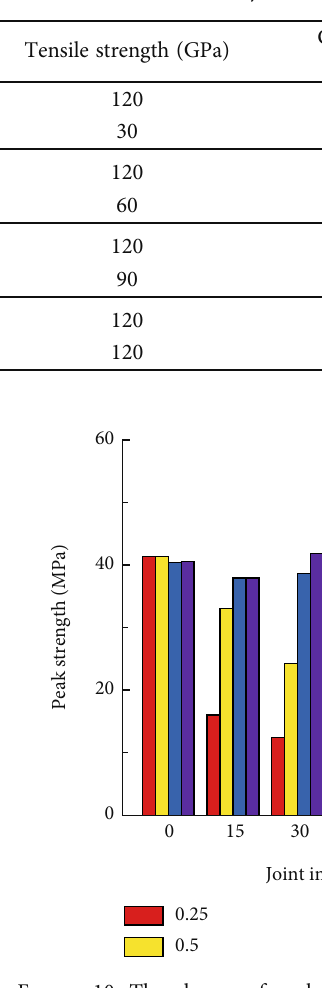
Figure 9: Uniaxial compression failure mode of rock samples with columnar Table 2: Numerical simulation parameters of rock mass with di ff erent joint strengths.